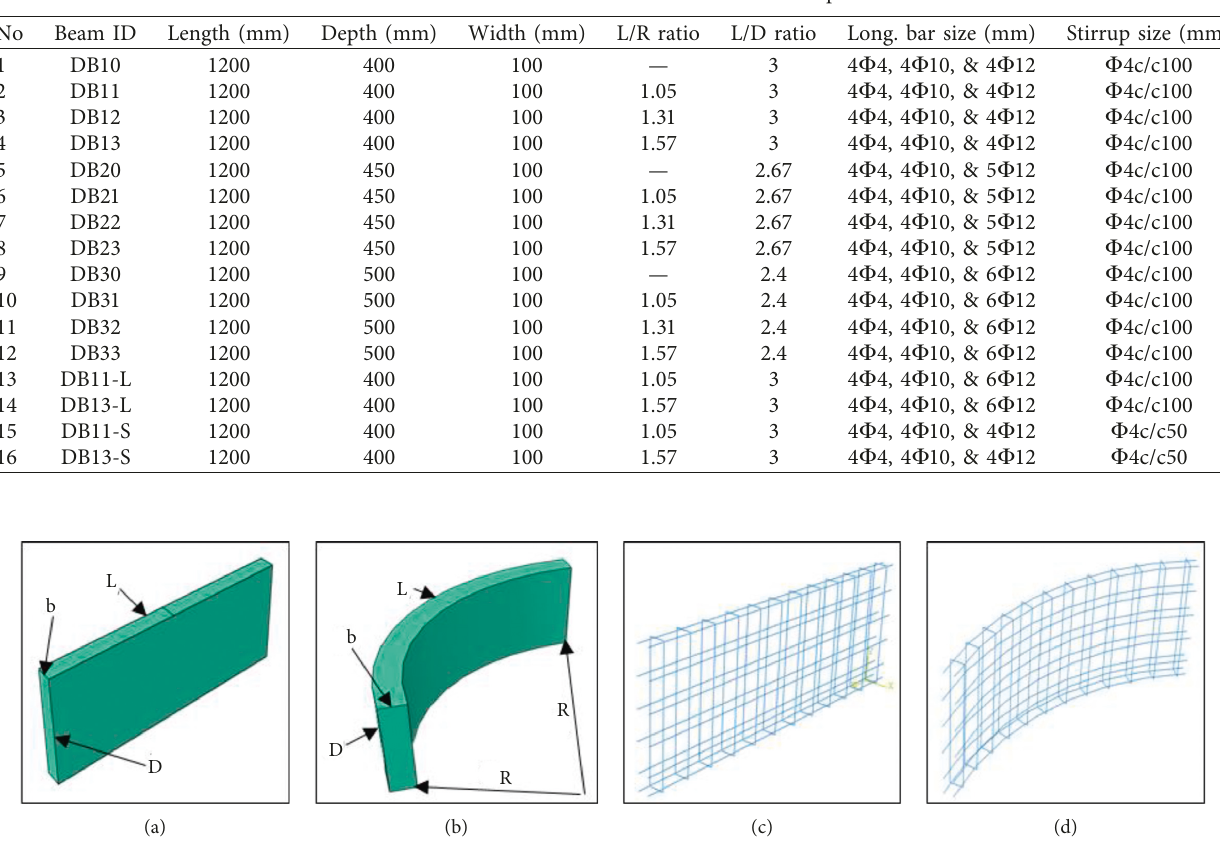
Figure 1: Sample geometric description of the deep beam and steel reinforcement. (a) Straight concrete plain beam, (b) curved concrete plain beam, (c) detailing for straight beam, and (d) detailing for curved beam.